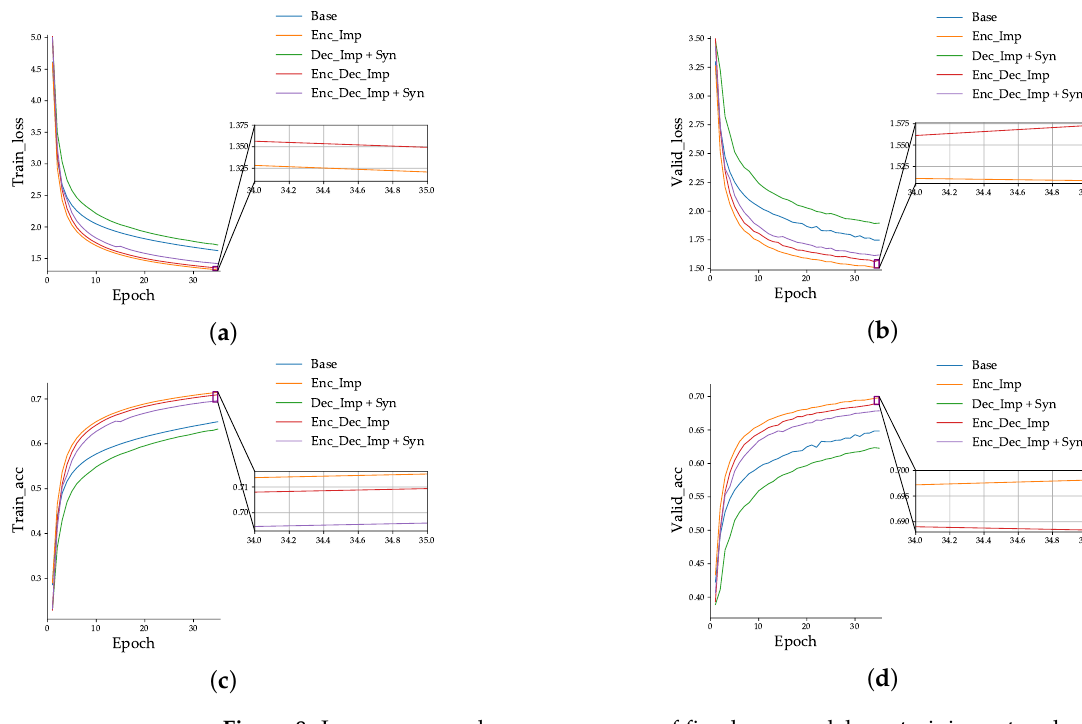
Figure 8. Loss curves and accuracy curves of five-layer models on training set and validation set. ( a ) Training set loss curve. ( b ) Validation set loss curve. ( c ) Training set accuracy curve. ( d ) Validation set accuracy